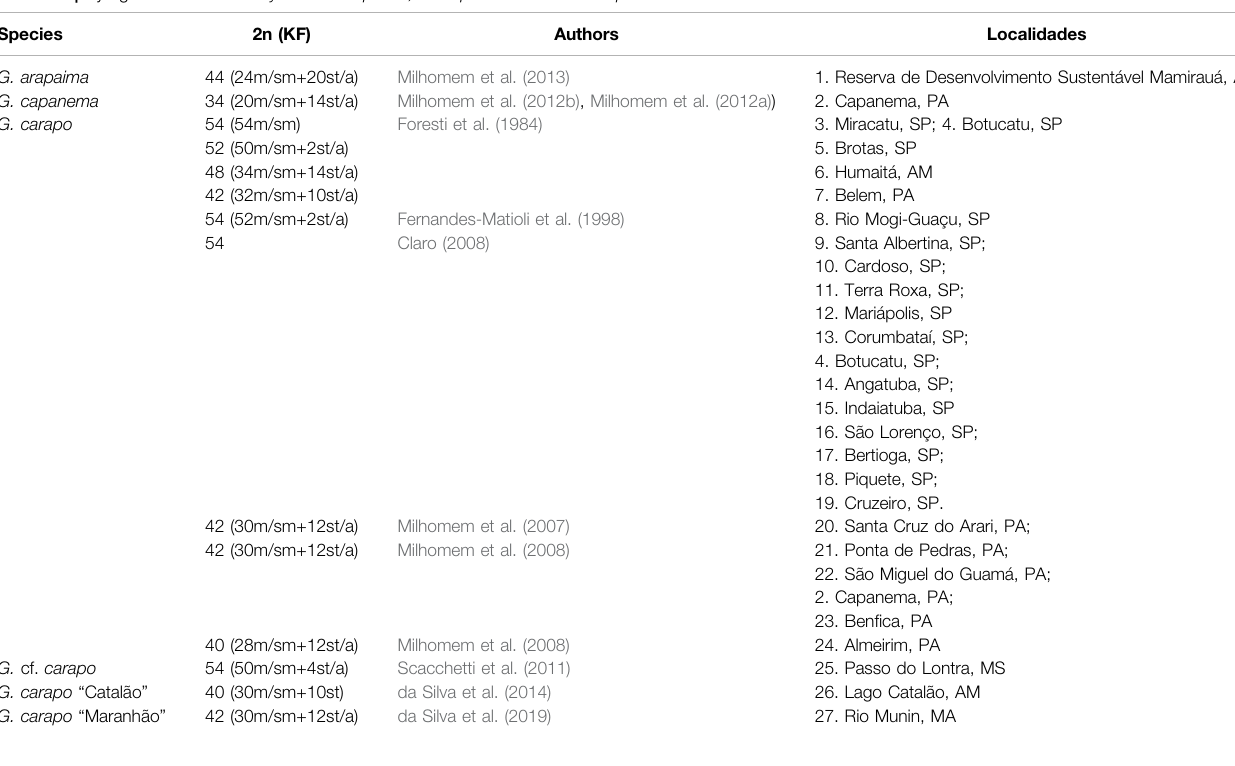
TABLE 1 | Cytogenetic studies of Gymnotus arapaima, G. capanema and G. carapo . Species 2n